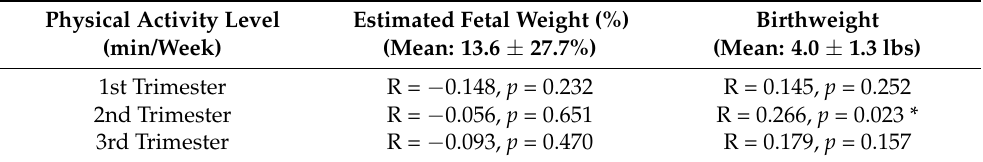
Table 3. Relationships between birthweight, estimated fetal weight, and physical activity levels dur- ing by trimester.